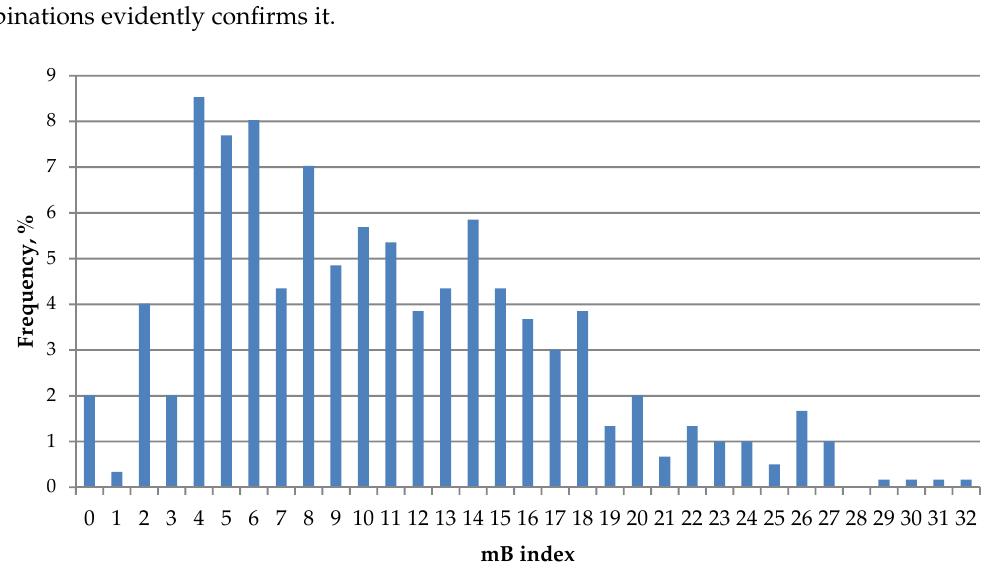
Figure 8. Frequency distribution of mB index values across studied A. peninsulae local populations.